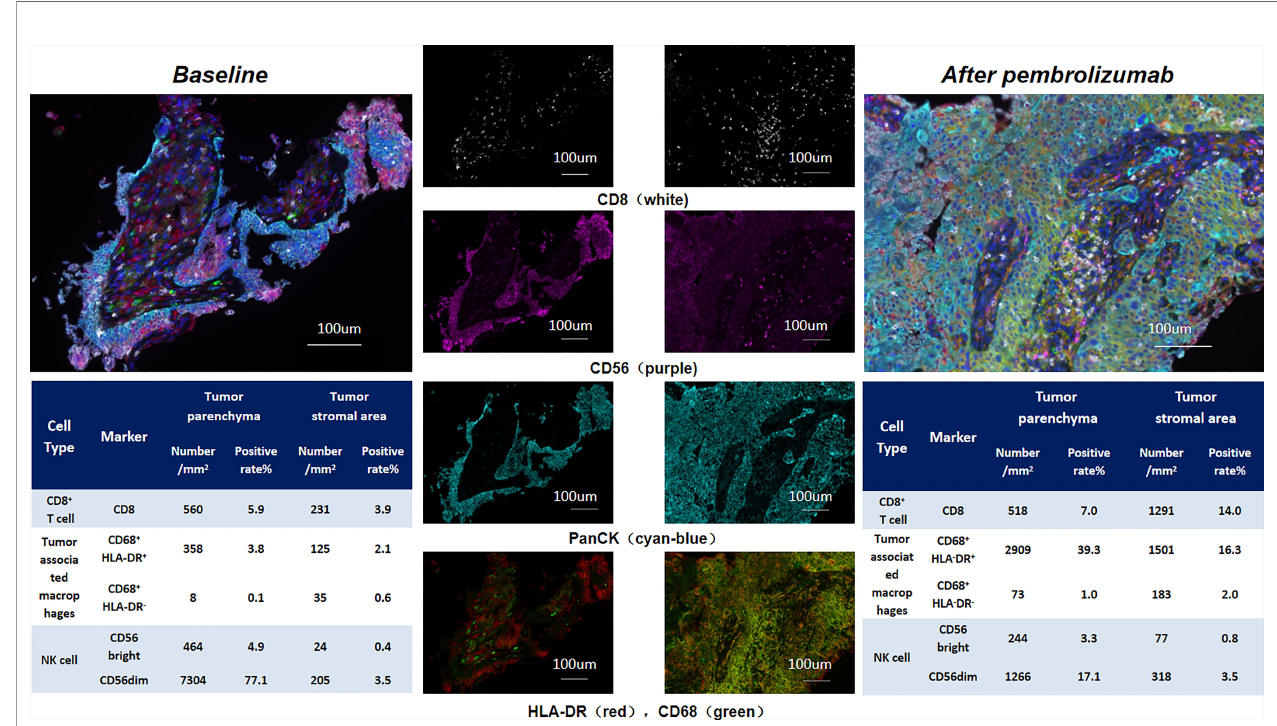
FIGURE 2 | Tumor mircoenvironmental features before and after pembrolizumab